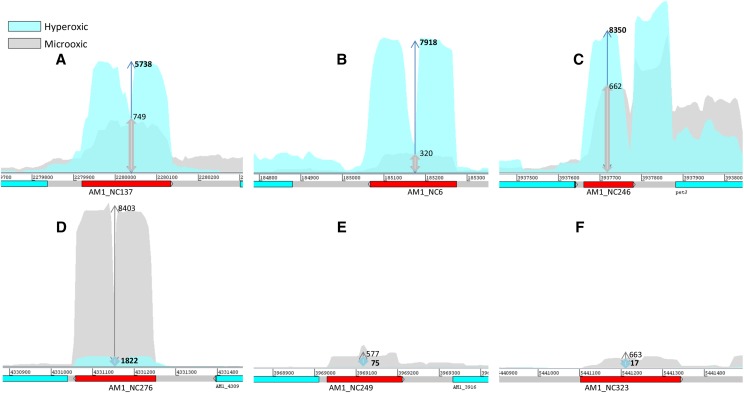
Noncoding RNAs regulated in opposing directions, under the two oxygen treatment conditions. (A–C) were induced under hyperoxic conditions; while (D–F) were induced under microoxic conditions. The arrows and the numbers adjacent to them represent relative expression. Chromosome coordinates are given above the gene representation. RPKM, reads per kilobase per million mapped reads.